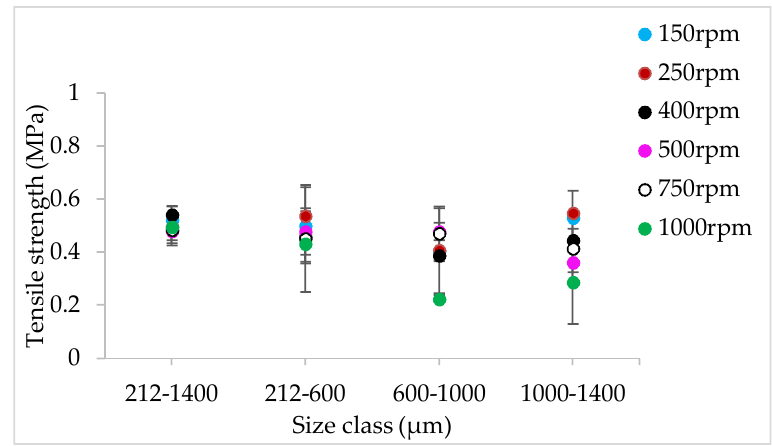
Figure 10. Tensile strength of tablets of lactose granules produced at varying screw speed at SFL—0.041 and PFN—1.71403 × 10 −5 (L/S 0.1).